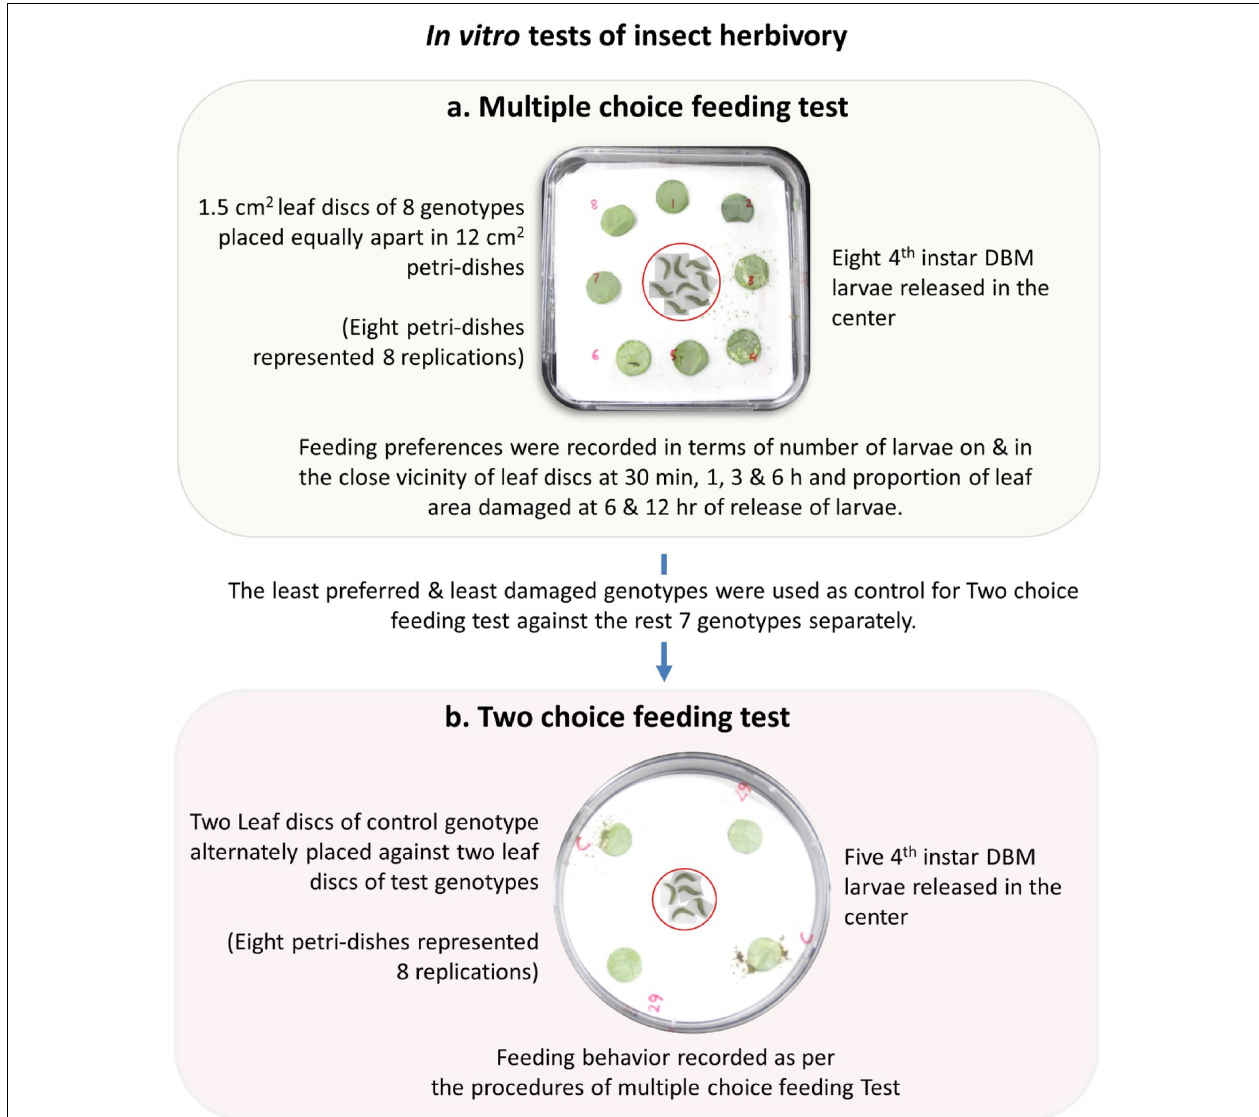
FIGURE 2 | Detailed procedure of in vitro insect herbivory used in the multiple-choice and two-choice feeding tests of fourth instar Diamondback larvae on the cabbage genotypes.